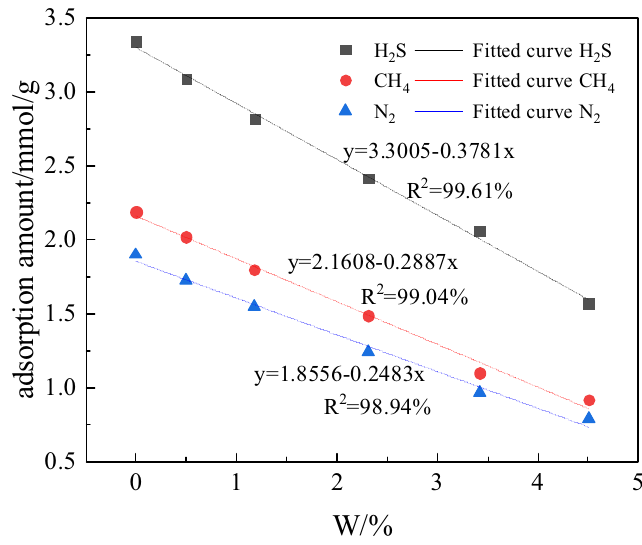
Figure 7. Adsorption of H 2 S, CH 4 and N 2 : correlation with water present in